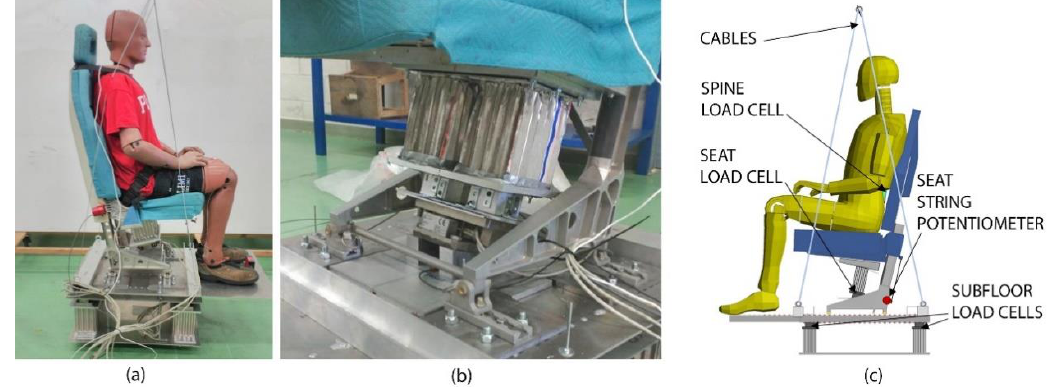
Figure 4. ( a ) Full mock-up before drop test; ( b ) detail of seat energy absorber, installed under the seat pan above the load cell; ( c ) mock-up and sensor layout